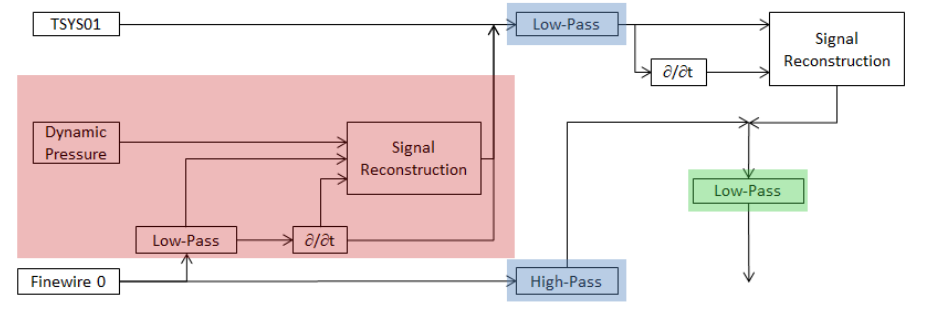
Figure 6. Reconstruction of the temperature signal for ALICE raw measurements. During the first step of the reconstruction, shaded in red, the influence of the housing is corrected via use of the fast fine-wire sensor. During the second step, indicated in blue, complementary low and high-pass filtering with a frequency of 1/30Hz is applied. During the final step, the signal is low-pass filtered. Subsequently, the actual reconstruction was performed with the low-pass filtered signal (<1/30 Hz) of the TSYS01 based on a PT1-element. A Butterworth filter of first order was applied (resulting in the green line in Figure 5, right panel). Finally the high-pass filtered signal (>1/30 Hz) of the fine-wire sensor was added to the reconstructed signal (process shaded in blue in Figure 6, resulting in the red line in Figure 5, right panel). For better visualization, based on the spectrum of the fine-wire signal, the combined signal was low-pass filtered at 2 Hz (process shaded in green in Figure 6). The result shows the combination of the low-pass long-term stable TSYS01 sensor with the high-pass filtered fast fine-wire temperature sensor (blue line in Figure 5, right